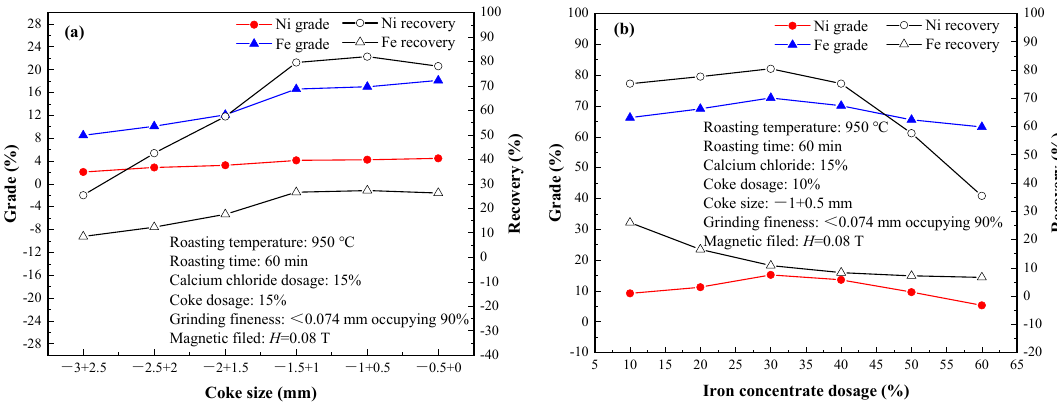
ff ect of coke size ( a ) and iron concentrate dosage ( b ) on nickel Figure 5. Effect of coke size ( a ) and iron concentrate dosage ( b ) on nickel extraction. Figure 5. E